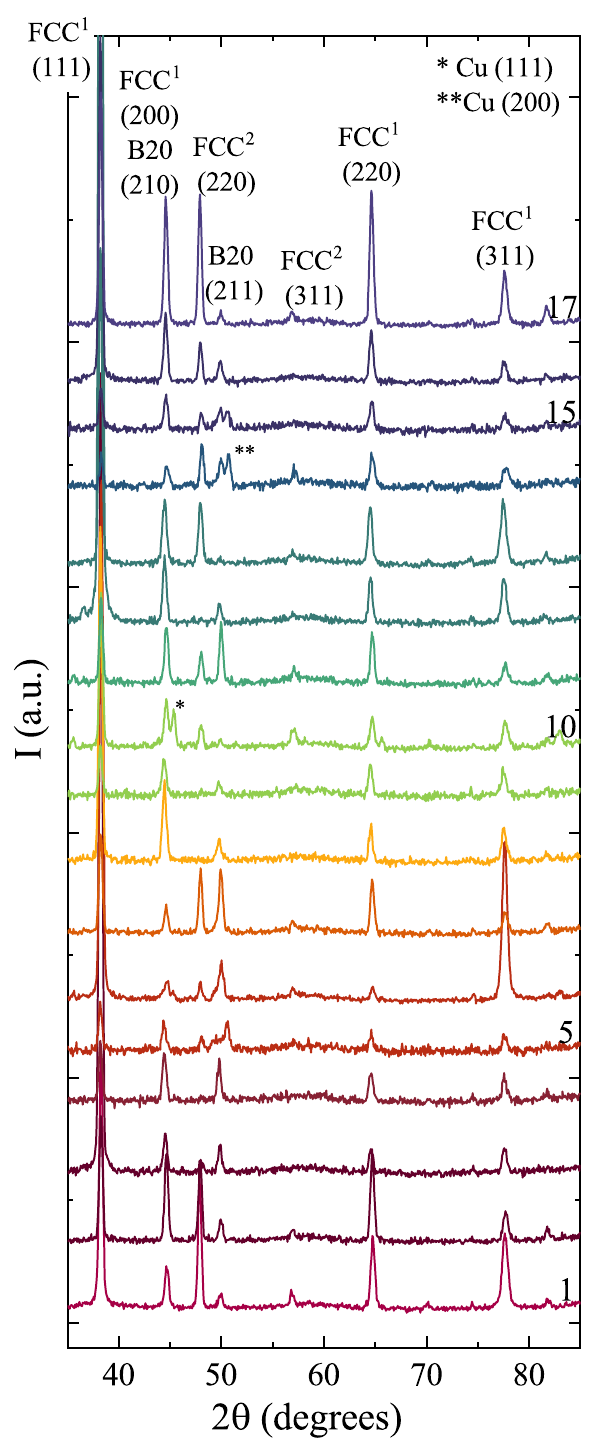
Figure 2. X-ray diffraction patterns captured at positions 1–17 after the